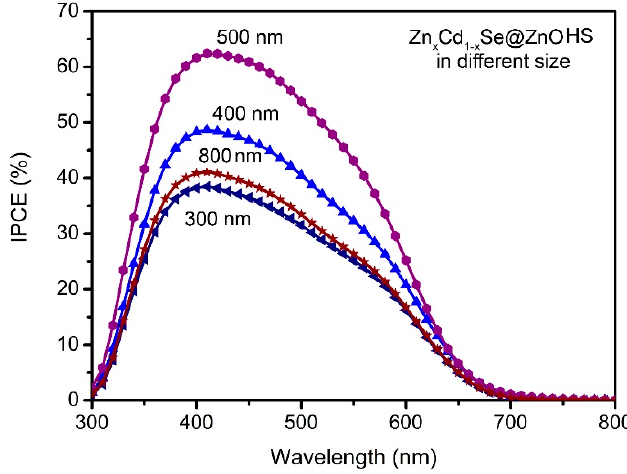
Figure 9. The incident photo-to-current conversion efficiency (IPCE) spectra of QDSSCs based on Zn x Cd 1-x Se@ZnO HS in the sizes of ~300, ~400, ~500, and ~800 nm, respectively.